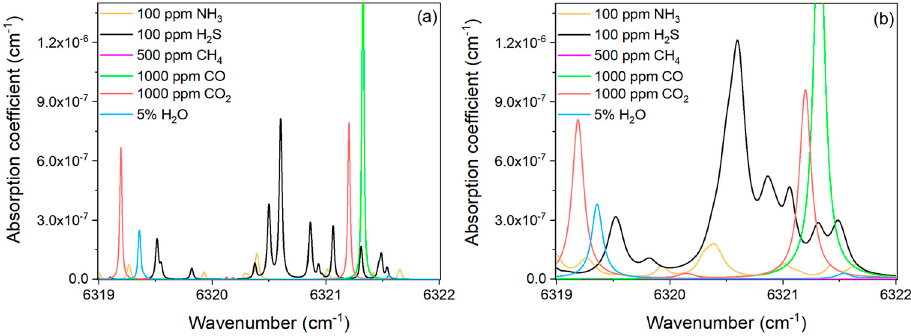
Figure 1. Absorption coefficient for NH 3 , H 2 S, CH 4 , CO, CO 2 , and H 2 O, based on the HITRAN database at 100 Torr ( a ), and 680 Torr ( b ).